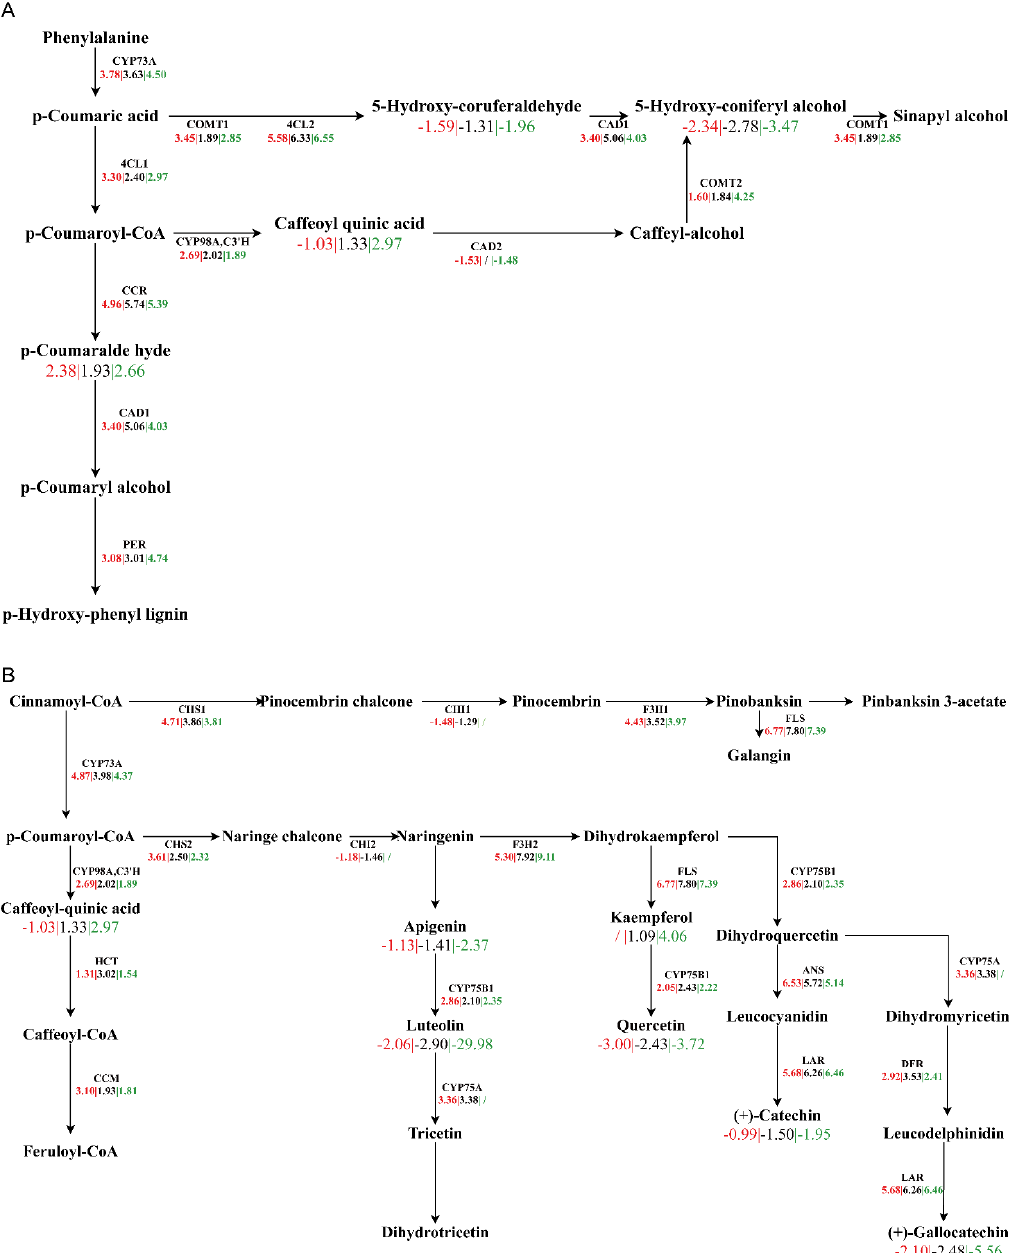
Figure 7. KEGG pathway enrichment of DEGs and DAMs, ( A ) with S2/S1, ( B ) with S3/S1, and ( C ) with S4/S1.